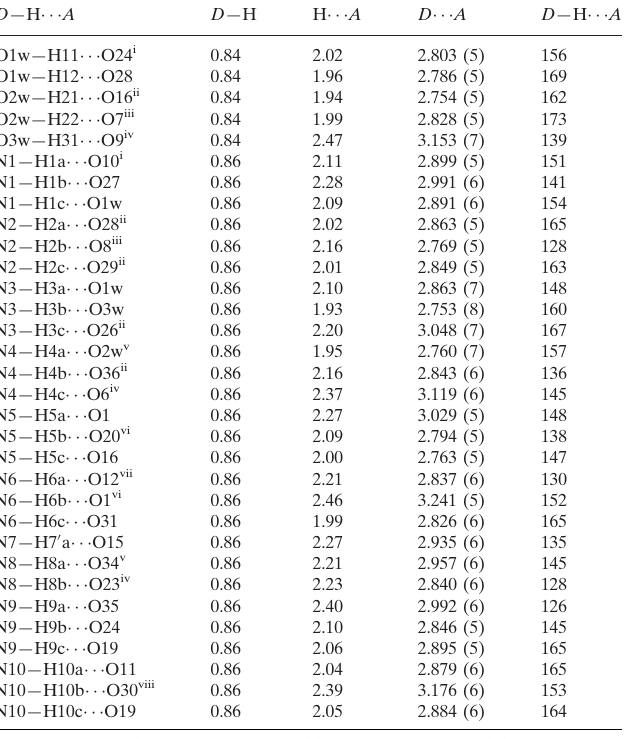
Hydrogen-bond geometry (A˚ , (cid:3)